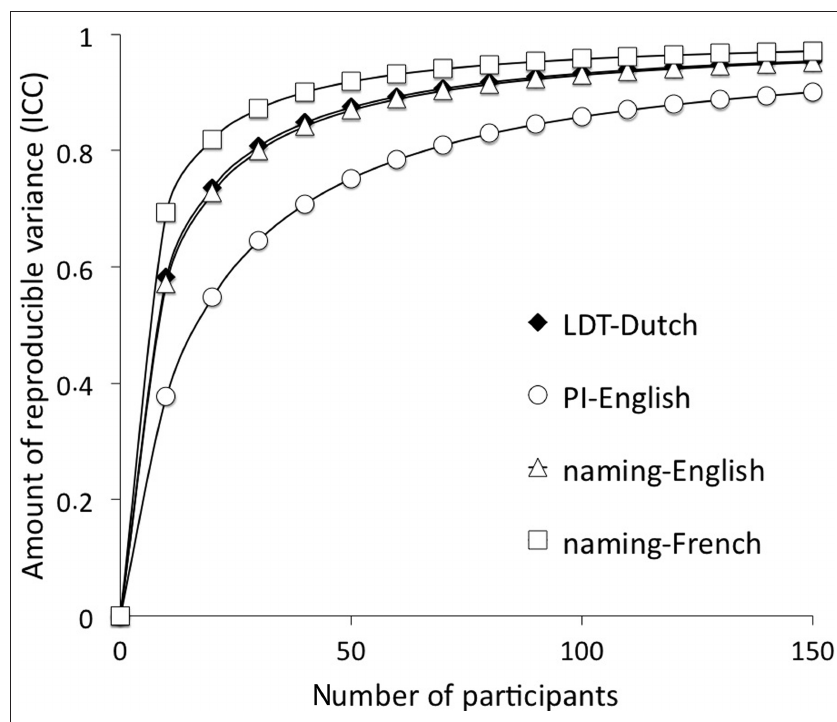
Figure 1 | evolution of the amount of reproducible variance iCC as a function of the number of participants in four databases: the DLP (Lexical decision task in Dutch, LDT-Dutch), rey et al. (2009; Perceptual identification task with english monosyllables, Pi-english), Courrieu et al. (in press; Naming disyllables in english and French: naming-english + naming-French). For each of these databases, the estimated q parameter was respectively: 0.1396, 0.0607, 0.1333,